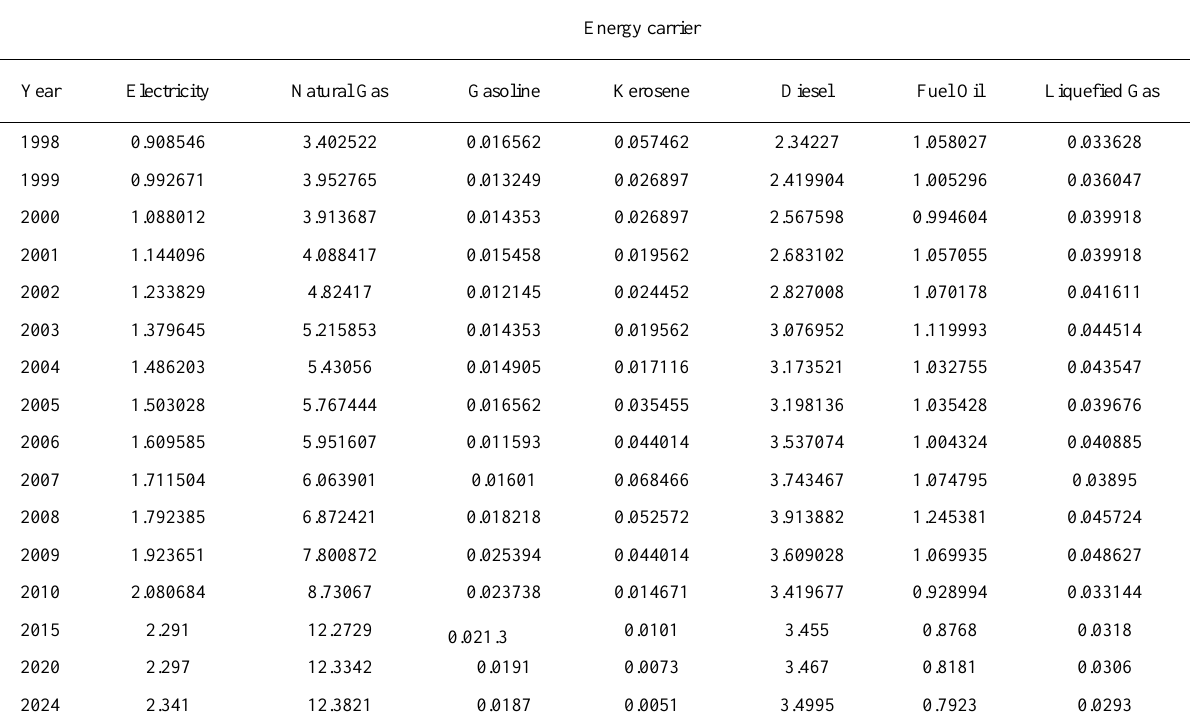
industry. Energy